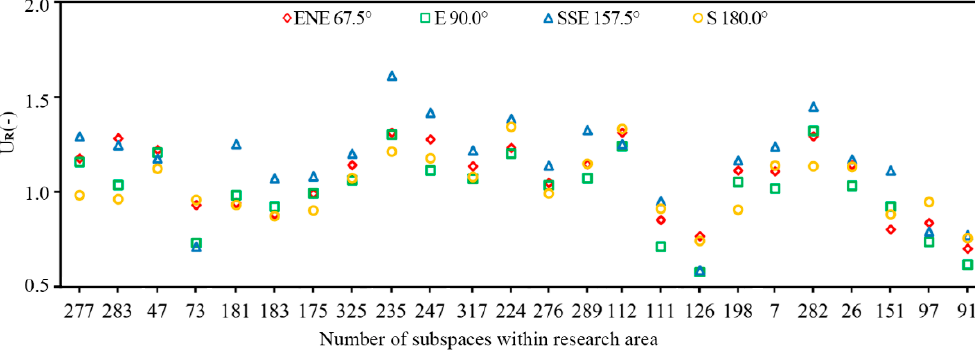
Figure 10. Mean wind velocity ratio (U R ) scatter diagram of 24 subspaces. Table 6. Correlation coe ffi cients of U R under four wind directions. Wind direction